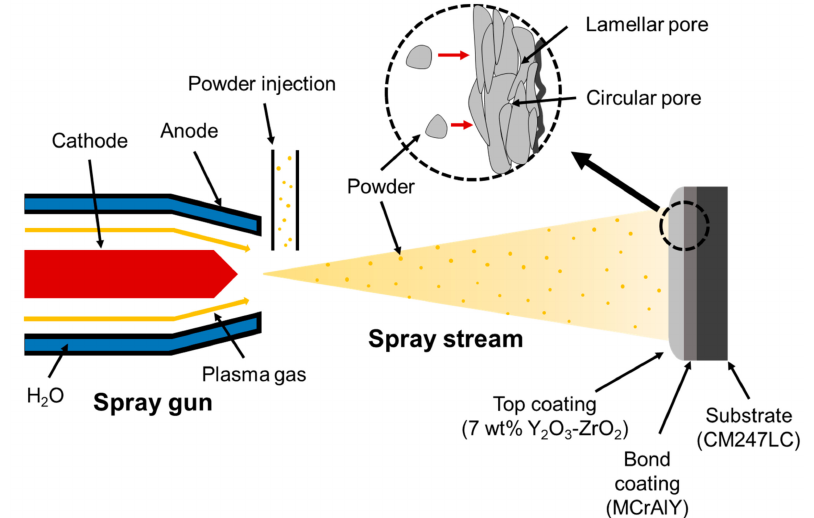
Figure 1. Schematic of APS system and TBC coating.